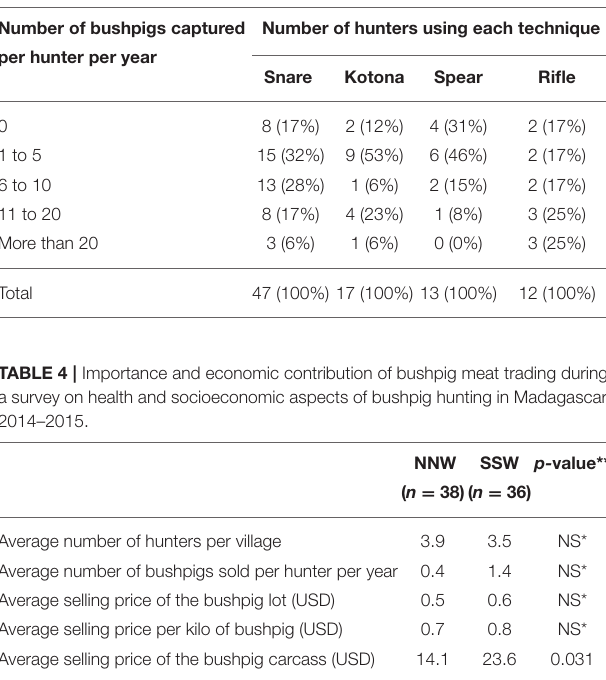
TABLE 3 | Number of bushpigs captured per hunter per year depending on the hunting technique used, during a survey on health and socioeconomic aspects of bushpig hunting in Madagascar, 2014–2015.